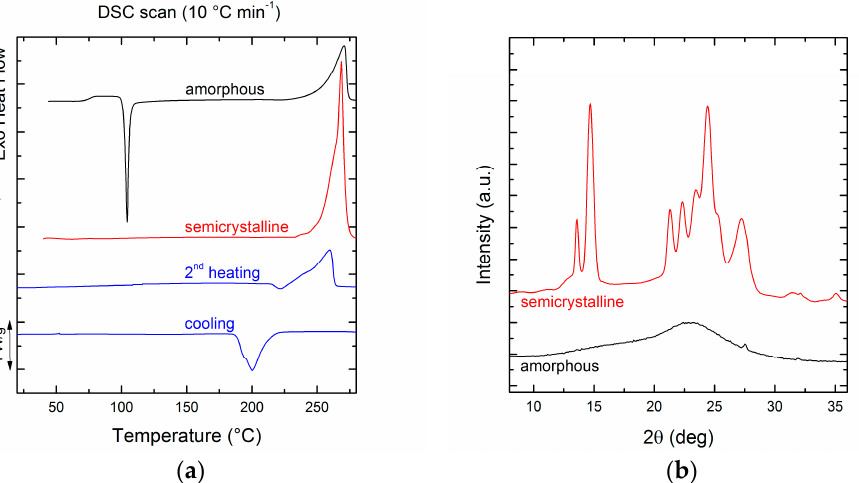
Table 1. Calorimetric data obtained from Differential Scanning Calorimetry (DSC) scans at 10 °C min − 1 . The enthalpies have been normalized by the weight fraction of the samples.